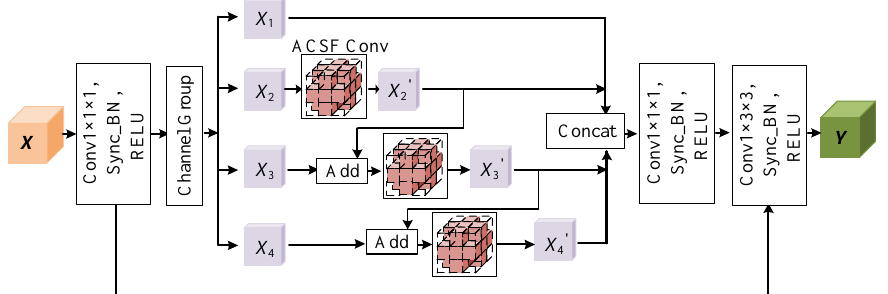
Figure 3. Hierarchical multi-view module based on ACSF convolution.